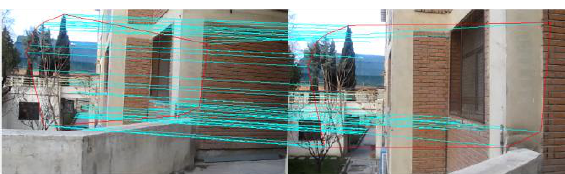
Figure 1. Inseparation of far from close obstacles in Al-Kaff et al's